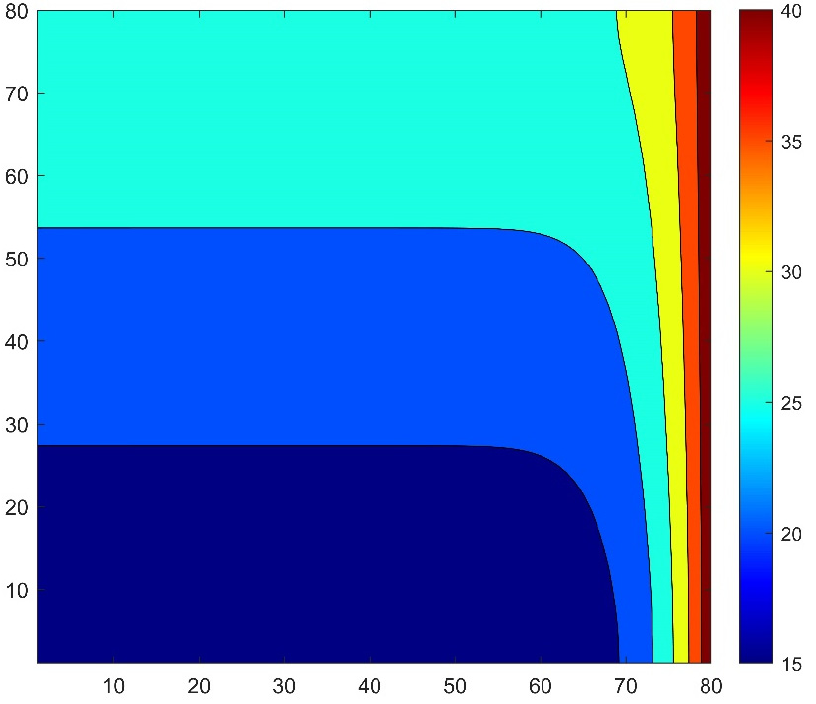
Figure 13. The temperature distribution contour for the equidistant mesh at the final time.